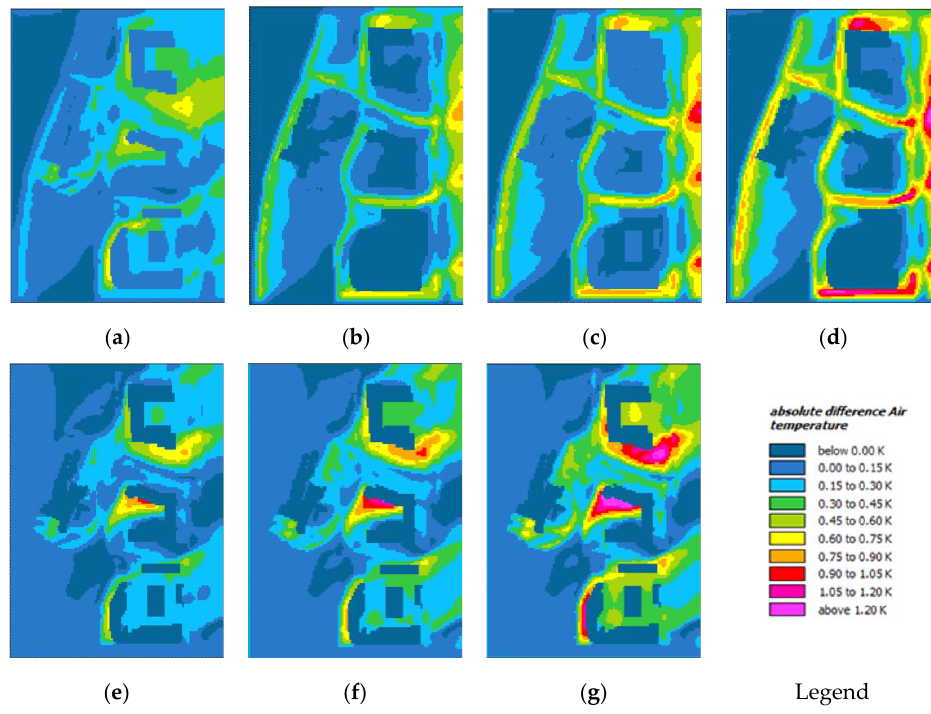
Figure 16. Difference in air temperature between each case and the base case at a height of 1.5 m at 15:00 for surfaces with different albedo values. ( a ) Asphalt albedo: 0.3 (difference between cases A7 and A0); ( b ) Asphalt albedo: 0.4 (difference between cases A8 and A0); ( c ) Asphalt albedo: 0.5 (difference between cases A9 and A0); ( d ) Asphalt albedo: 0.6 (difference between cases A10 and A0); ( e ) Masonry albedo: 0.4 (difference between cases A11 and A0); ( f ) Masonry albedo: 0.5 (difference between cases A12 and A0); ( g ) Masonry albedo: 0.6 (difference between cases A13 and